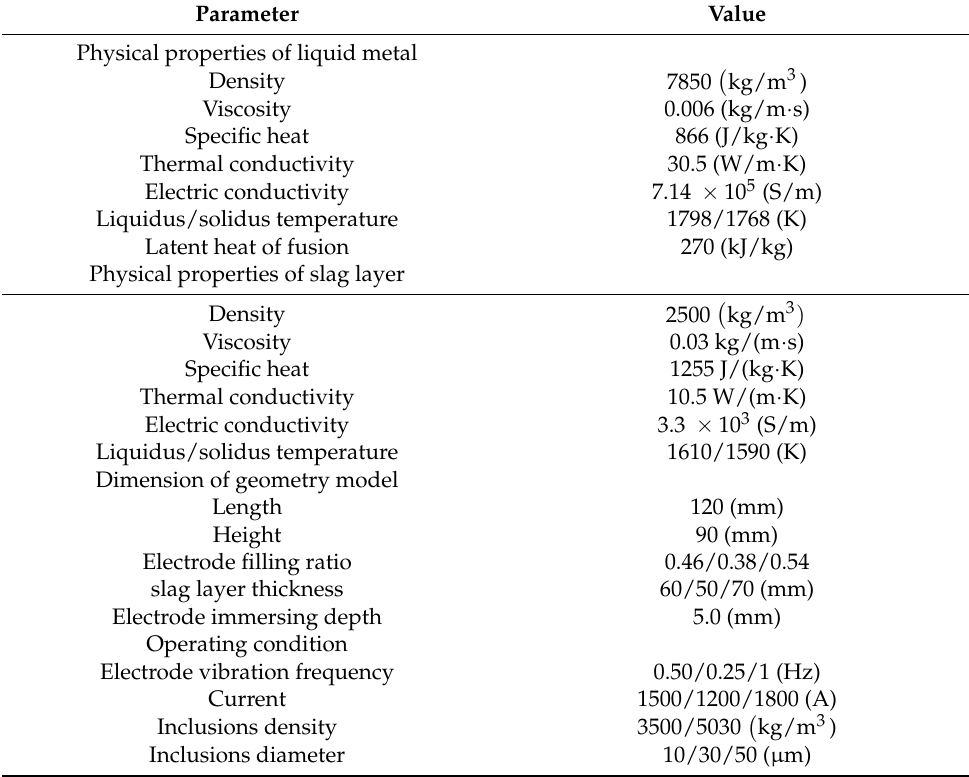
Figure 1. Grid simulation diagram. Table 1. Physical properties, geometry and process